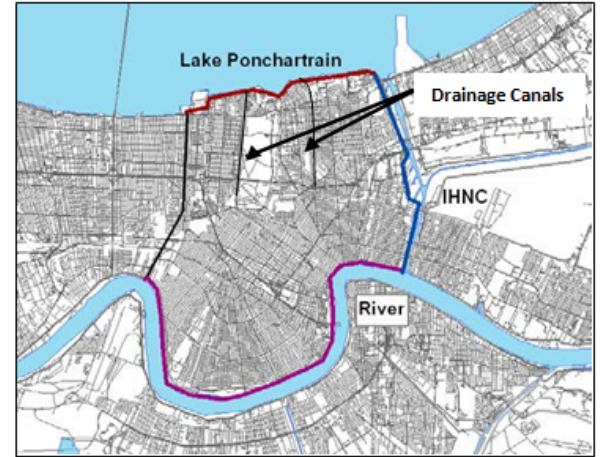
Figure 4. System boundaries for the New Orleans metro